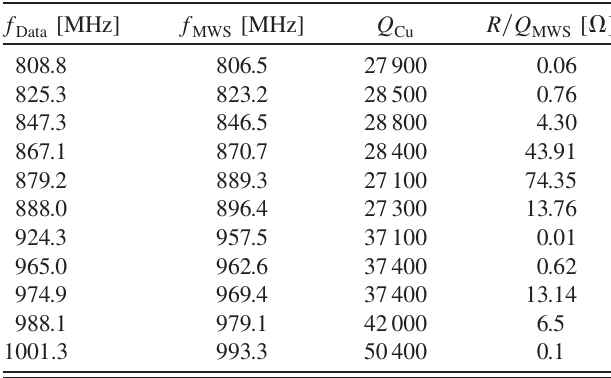
TABLE II. Dipole pass bands in the Cu cavity.